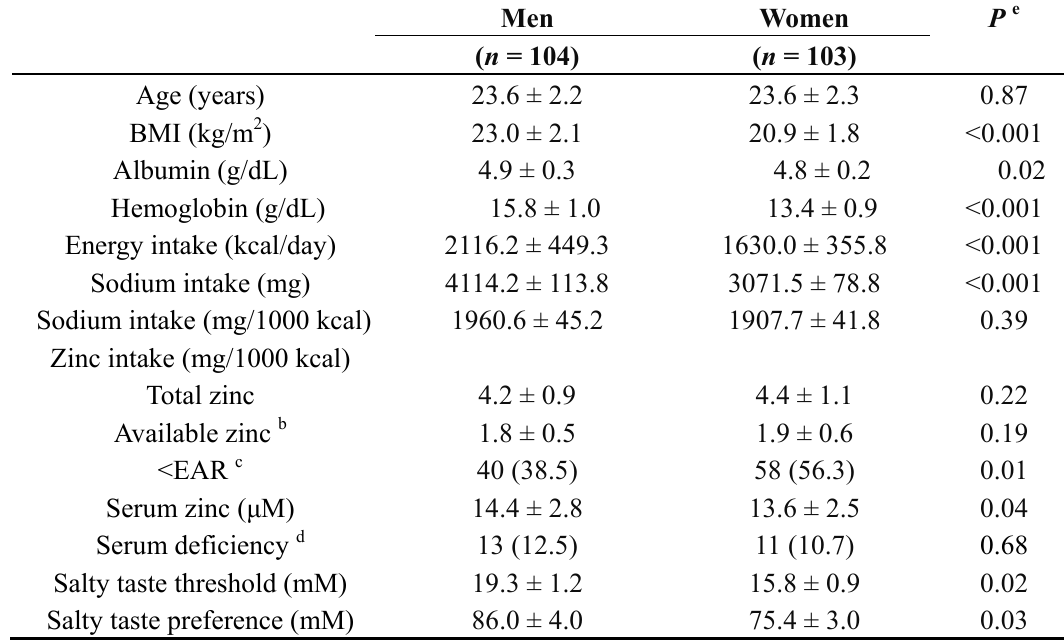
Table 1. General characteristics of study subjects a .